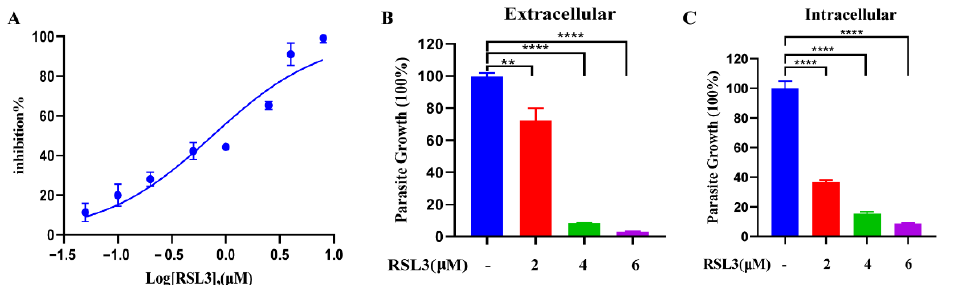
Figure 6. Evaluation of the anti- Toxoplasma effect of RSL3. ( A ) RSL3 can potently inhibit the growth of T. gondii . Vero cells were infected with 1 × 10 5 tachyzoites and treated with different concentrations of RSL3 for 24 h. The inhibition rate was then calculated based on the relative RLU in each treatment group and DMSO control. ( B ) The effect of RSL3 on extracellular parasites. Fresh extracellular tachyzoites (1 × 10 5 ) were pretreated with 0, 2, 4, and 6 µM RSL3 for 4 h and then inoculated into cells and cultured in drug-free medium for 20 h. DMSO was used as a solvent control. The inhibition rate was calculated using the RLUs of the RSL3- and DMSO-treated groups. ( C ) The effect of RSL3 on intracellular parasites. Tachyzoites were allowed to infect the cells for 4 h, and then non-invasive tachyzoites were removed, and the remaining parasites were cultured for 20 h in medium containing 0, 2, 4, and 6 µM RSL3. Statistical analysis used Student’s t -tests (** p < 0.05, and **** p < 0.001). Experiments were performed in triplicate.